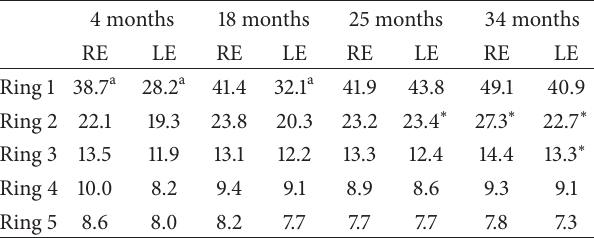
Table 1: P1 amplitudes (nv/deg 2 )